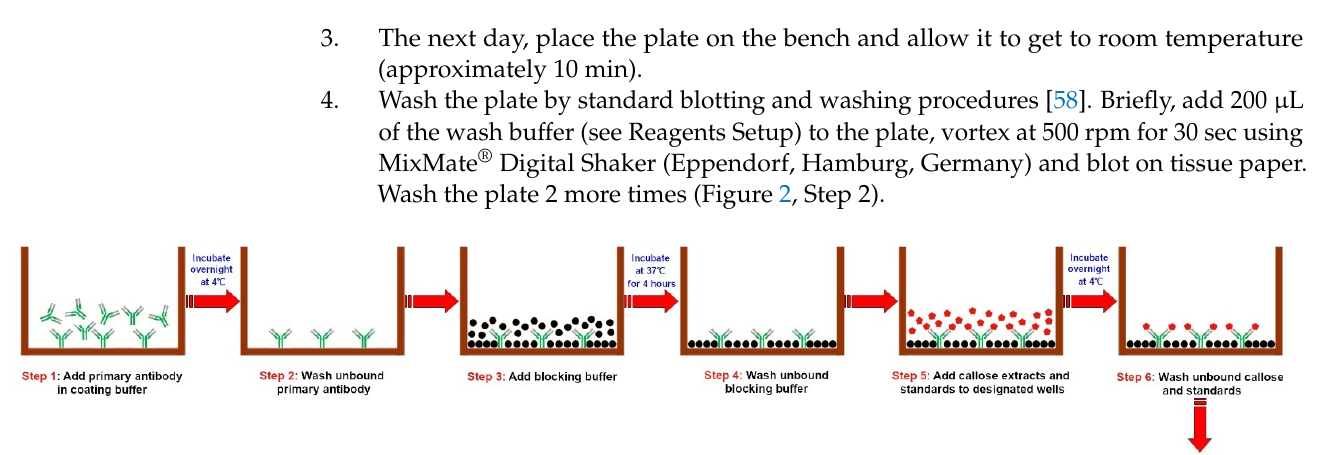
Figure 1. Schematic illustration of the major steps involved in callose